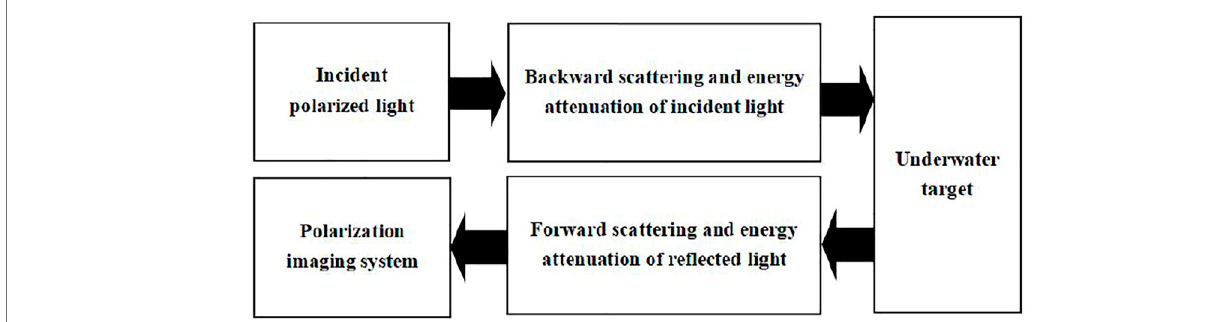
FIGURE 7 | The fl ow chart of light propagation in underwater environment.